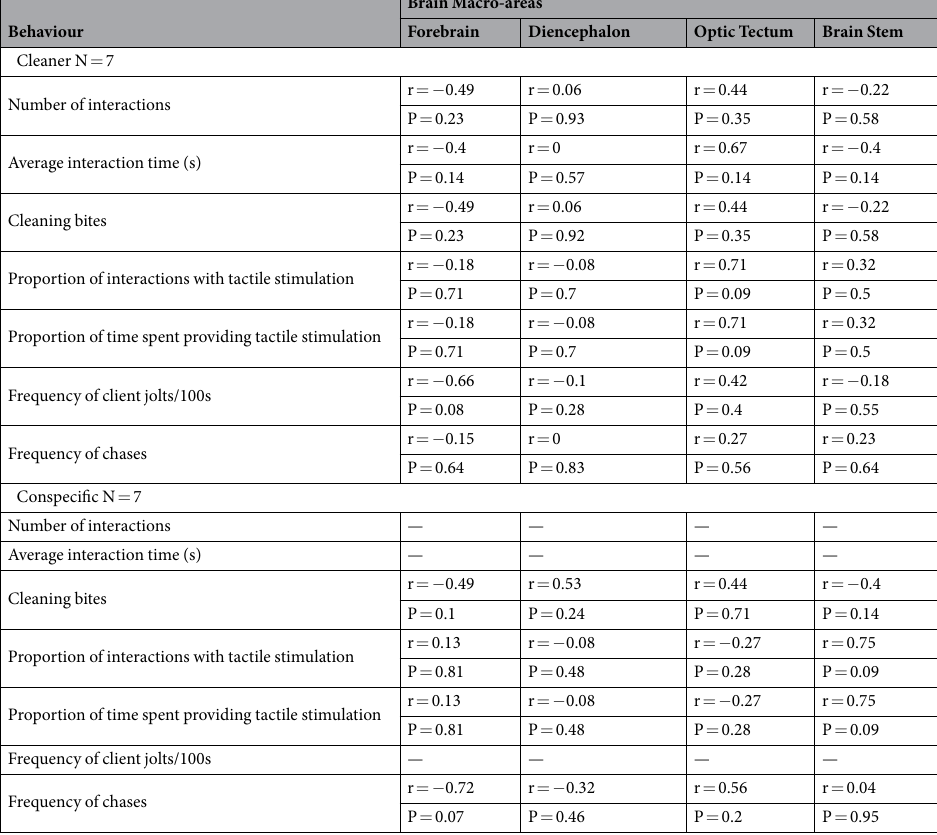
Table 3. Correlations (Spearman correlation coefficients) between each behavioural measure and dopamine levels in different brain macro-areas for the two experimental treatments: client introduced to a cleaner ( Labroides dimidiatus ) or to a conspecific ( Naso elegans ). There were no statistically significant correlations.